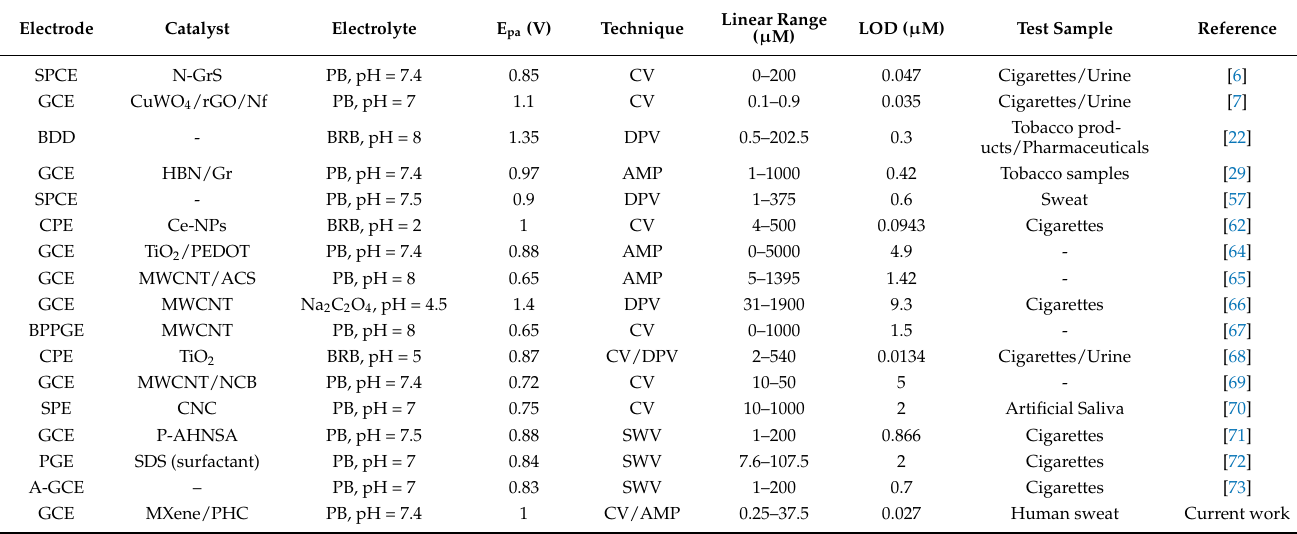
Table 1. Electrochemical detection of NIC using various electrochemical sensors and compared with our